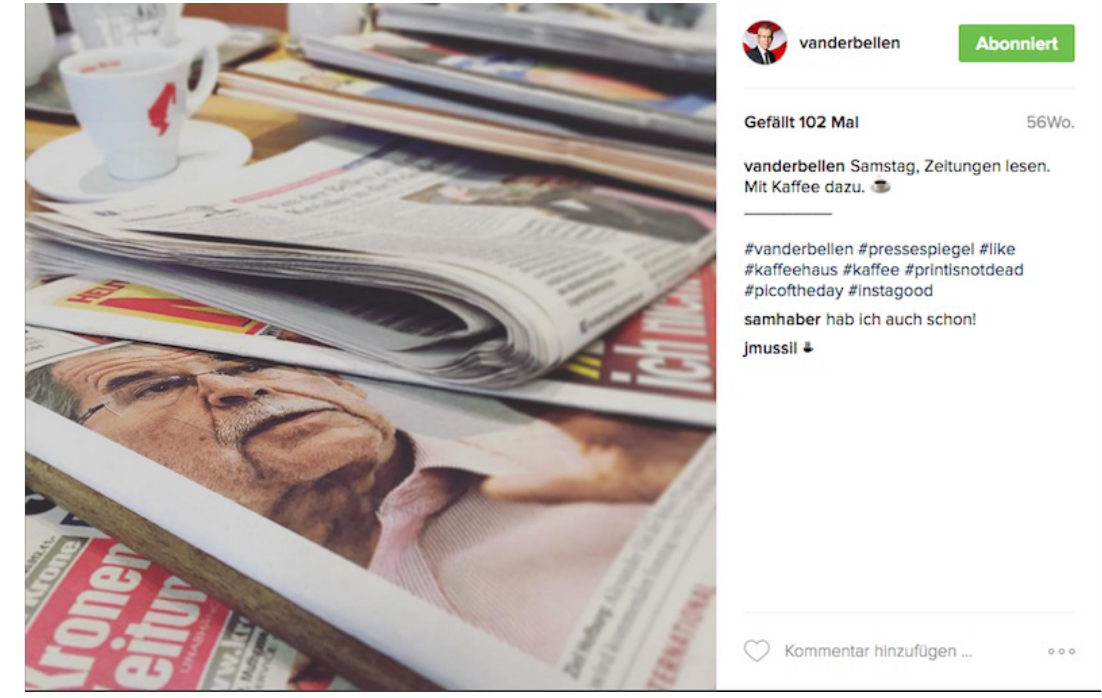
Figure 5. Coffee and Newspapers, posted on 9 January 2016. or welcome ceremony, or shaking hands), discussion (n = 18; Van der Bellen was frequently presented in debates with young voters) and endorsement (n = 17; which showed mostly prominent supporters, e.g. in March, April and May 2016) underscore the political im- portance of the